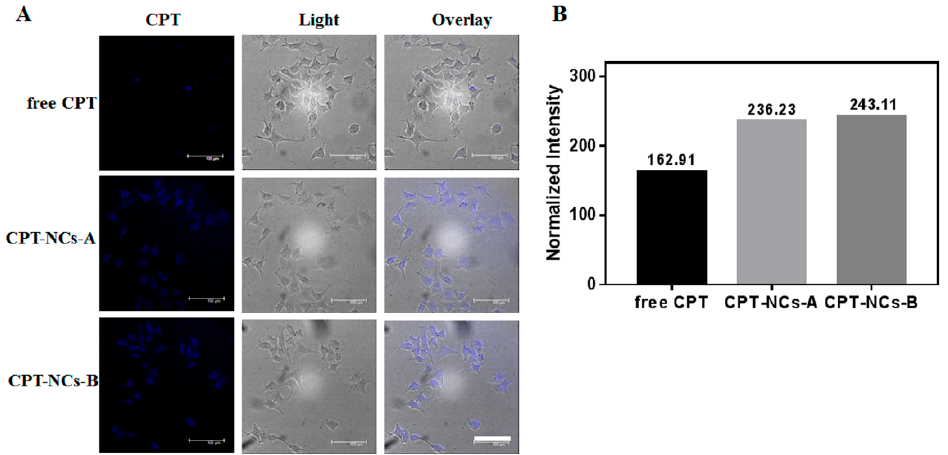
Figure 4. ( A ) confocal laser scanning microscope (CLSM) of SCC-15 cells after treatment with free CPT, CPT-NCs-A, and CPT-NCs-B for 4 h. Scale bar = 100 μ m; ( B ) The quantitative fluorescence intensity of squamous cell carcinoma (SCC-15) cells after treatment with free CPT, CPT-NCs-A, and CPT-NCs-B for 4 h by Image-Pro Plus.